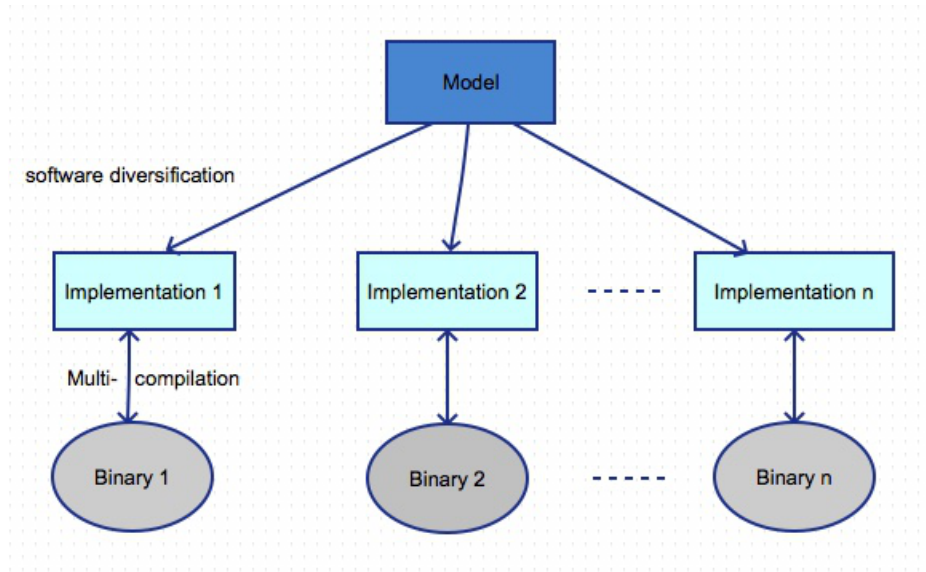
Figure 3. Layered implementation-based diversity